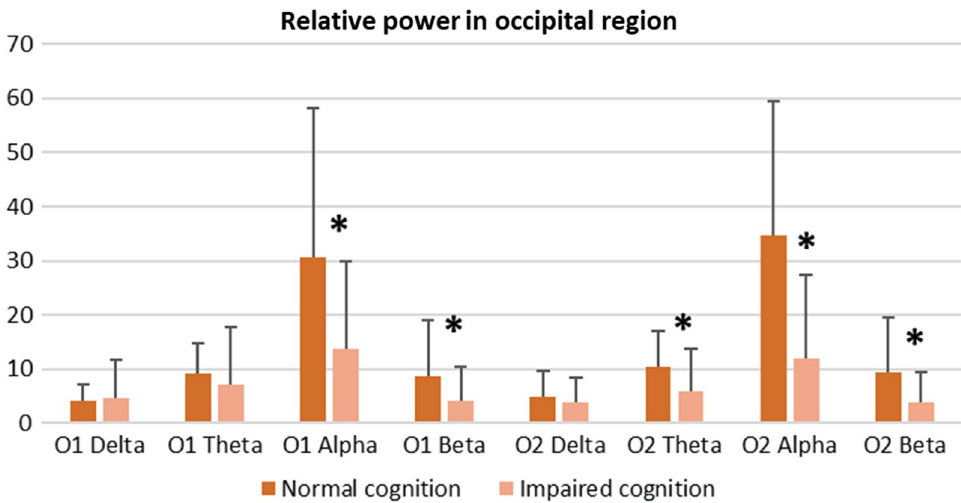
Fig. 4 Relative power in occipital region of the patients with normal and impaired